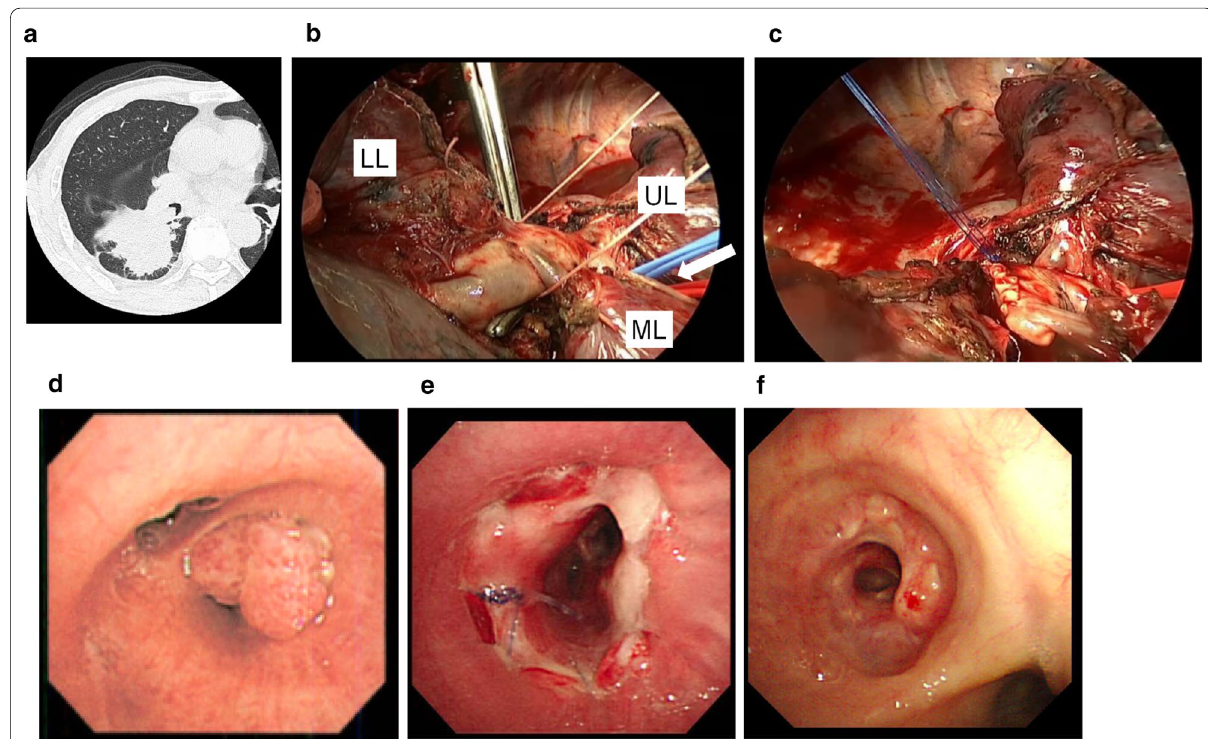
Fig. 2 Images of a representative case (case 2). a Computed tomography image before surgery. b Intraoperative photograph. Because the tumor invaded the lower pulmonary artery, the pulmonary branch to the middle lobe was not preserved by an auto‑suturing device or simple ligation. Interlobar dissection between the upper and middle lobes had already been performed; white box arrow. UL: upper lobe, ML: middle lobe, LL: lower lobe. c Angioplasty of the pulmonary artery was performed. Bronchoscopic findings. d Before surgery. The tumor occluded the orifice of the lower bronchus. e One week after surgery. The stump of the middle lobe bronchus was completely within the truncus intermedius. f Six months after surgery. The anastomotic site was covered with clean mucosa and the patency was good